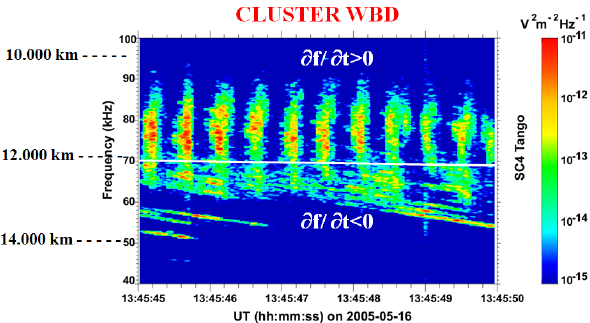
Figure 9. Spectrogram covering a period of 5s showing pulsed and striated AKR observed by remote sensing on a Cluster satellite lo- cated in the nightside magnetosphere at 14.2 R E and at invariant latitude of 80 ◦ . The horizontal white line indicates the value of the local gyrofrequency f ce ∼ 70kHz at an altitude of ∼ 12000km (adapted from Pottelette and Pickett,